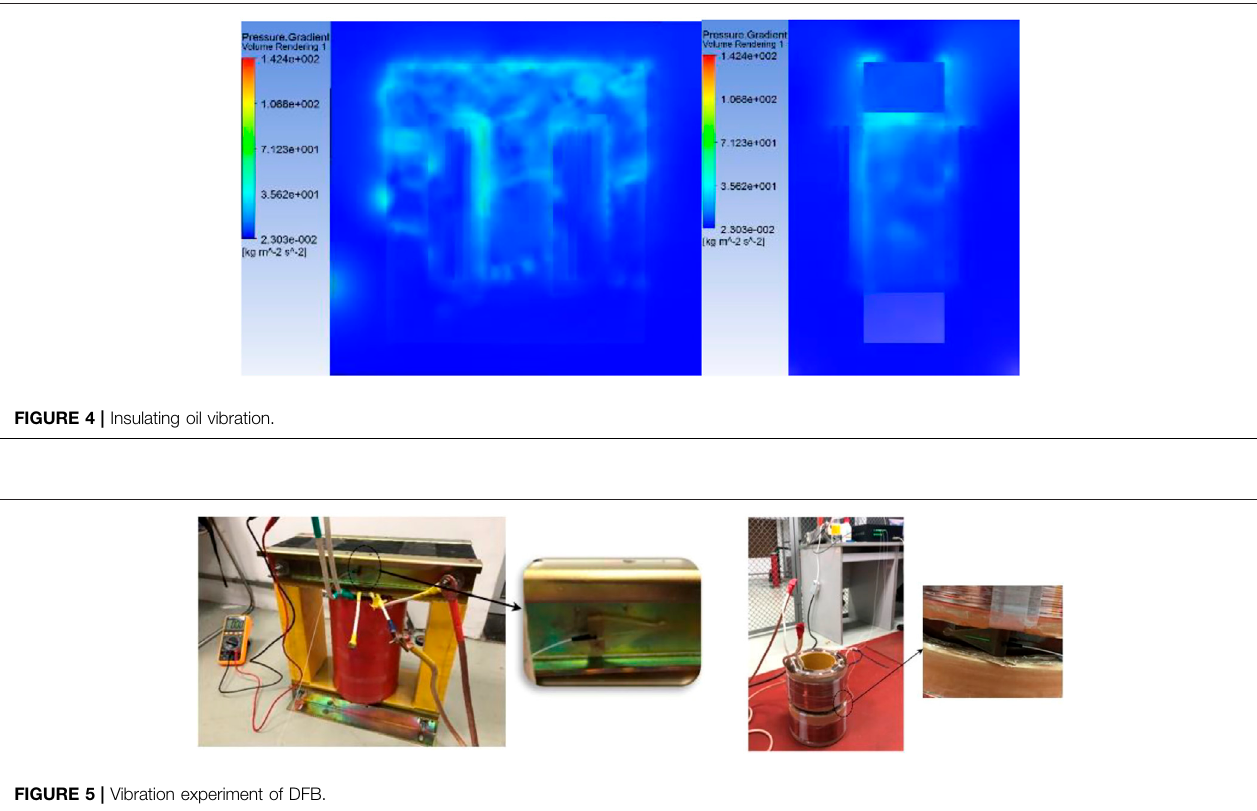
FIGURE 5 | Vibration experiment of DFB.